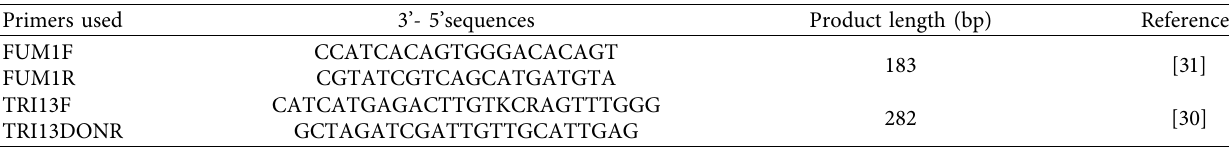
Table 1: The list of primers used to detect the potential of the Fusarium spp. isolated from grains of wheat genotypes to produce DON and fumonisins. Primers